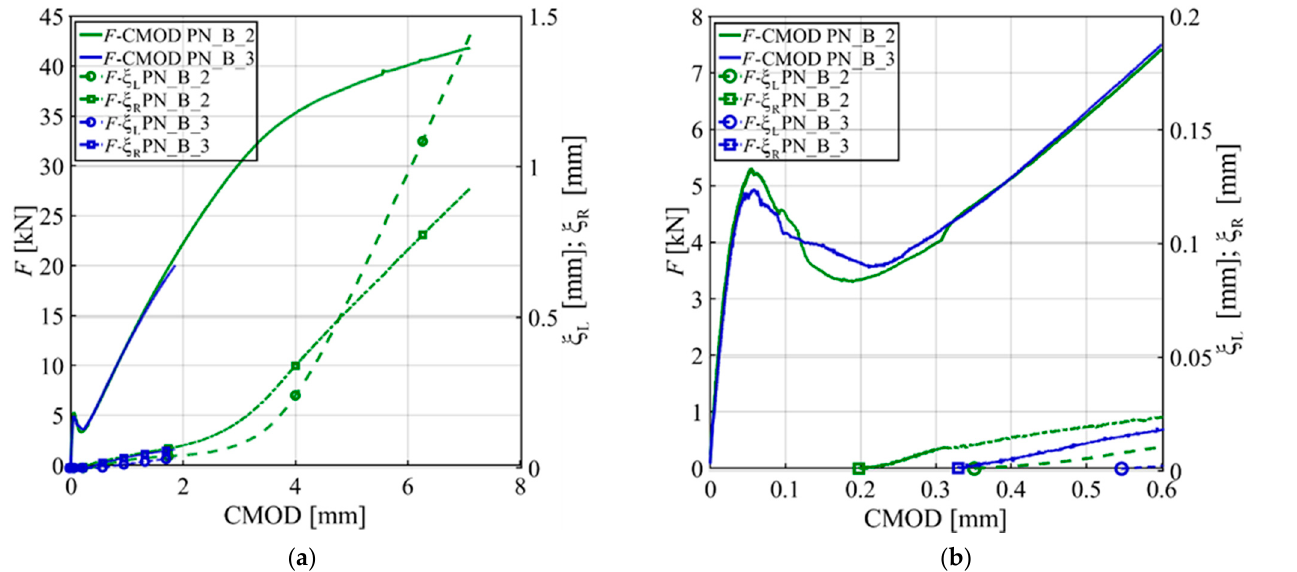
Figure 8. Plots of free end movement of GFRP bars: ( a ) CMOD is plotted against F and ξ R and ξ R for PN_B_2 and PN_B_3; ( b ) A call out for the first segment of Figure